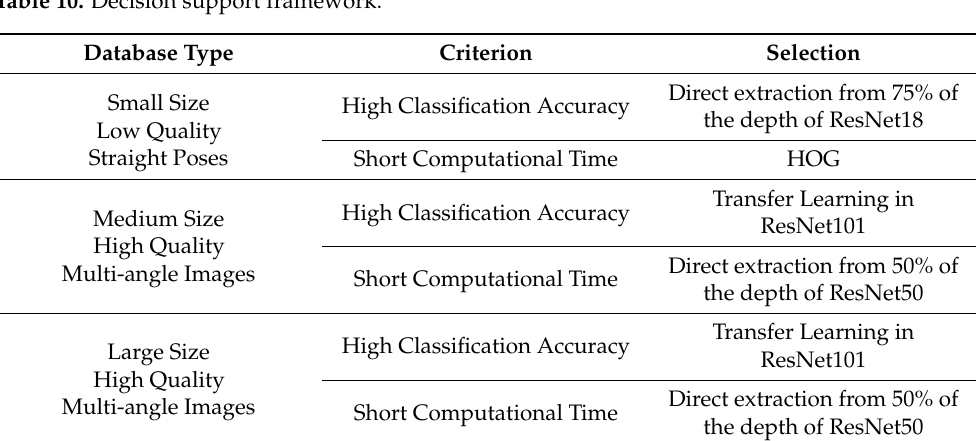
Table 10. Decision support